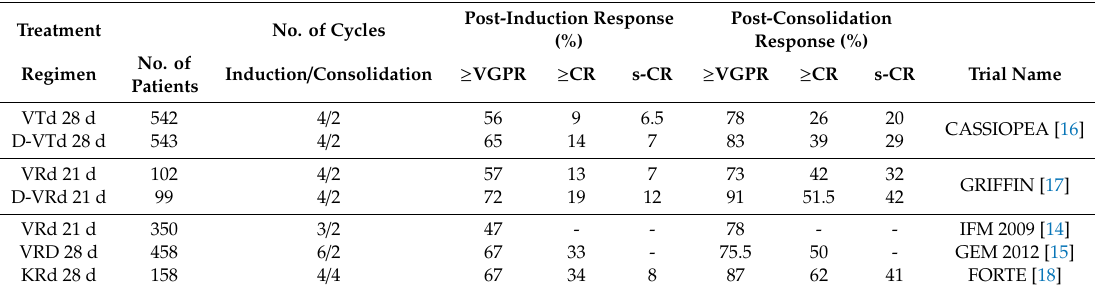
Table 1. Results of induction / consolidation therapies in ASCT-eligible